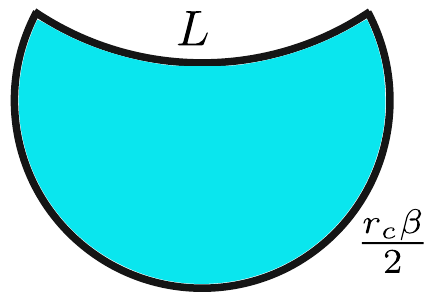
Figure 7 . Saddle point for the L -basis Hartle-Hawking wave